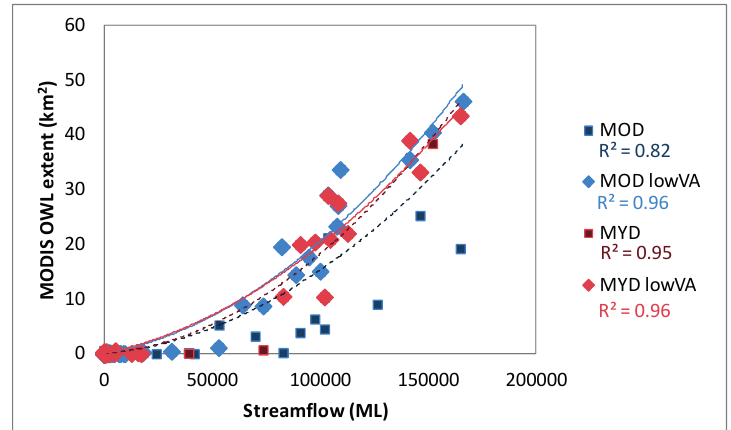
Figure 9. MODIS OWL flood extend plotted against streamflow for Site W2 for the 2003, 2004, 2009 and 2010 wet seasons. The data with a low view angle (lowVA), or range distance less than 1000 km, are shown in the large diamond